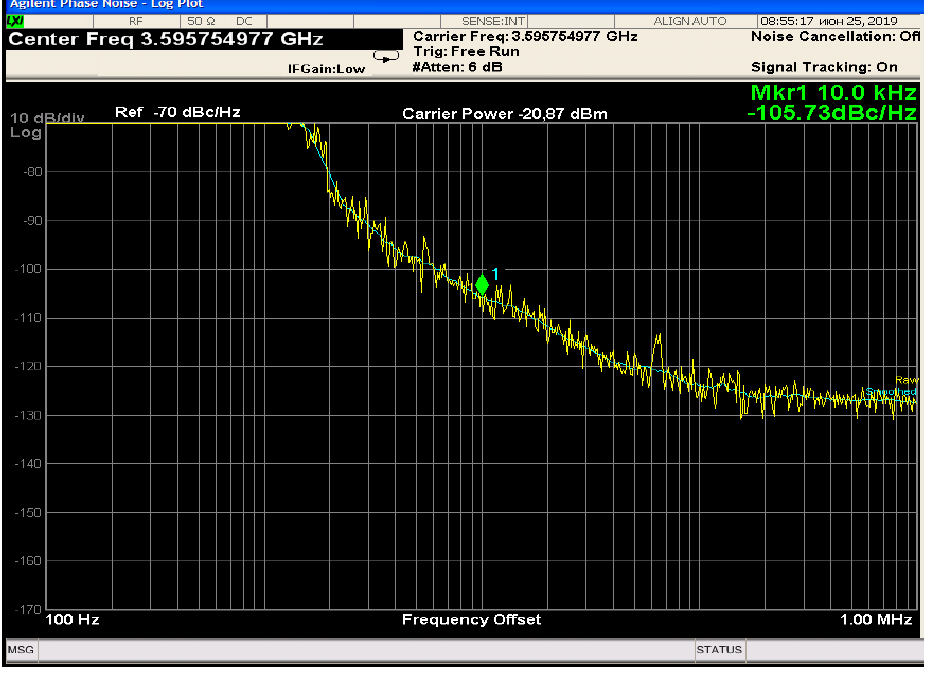
Fig. 5. VCO NSPD value at the offset of 10 kHz from the carrier 3.6 GHz without